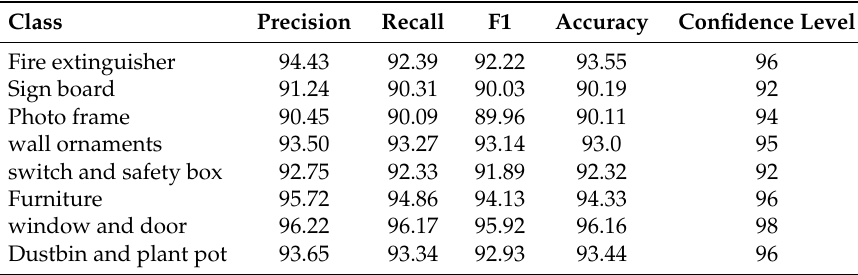
Table 2. Performance measures-SSD